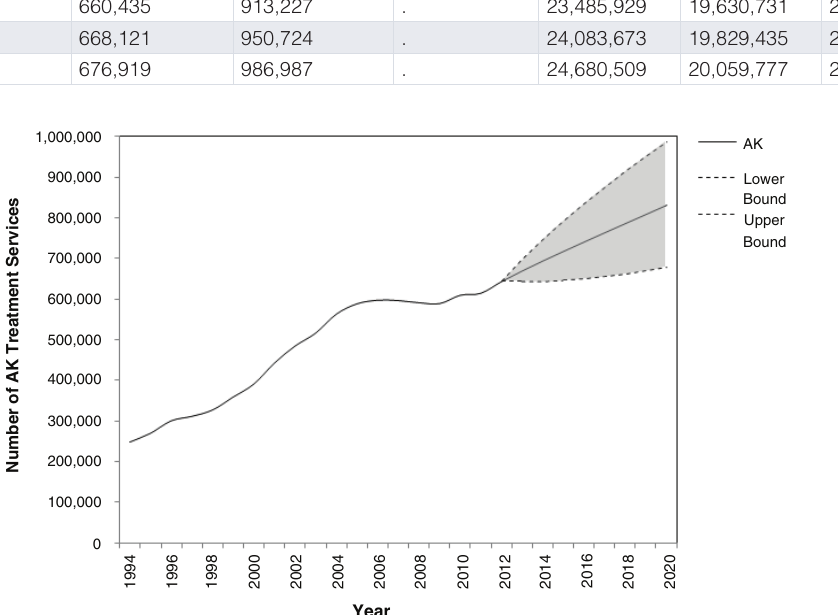
Table 1. Total number of AK treatments, total costs inflated, total costs without inflation and forecasts of AK numbers and costs with upper and lower 95% confidence limits (UCL95 and LCL95). Number of AK Number of AK Total cost in Total cost Total cost Number of AK Total cost Year Treatments Treatments non-deflated in 2012 AU$ in 2012 AU$ Treatments in 2012 AU$ LCL95 UCL95 AU$ LCL95 UCL95 1994 247,515 . . 5,592,597 9,094,440 . . 1995 269,252 . . 6,168,831 9,587,787 . . 1996 299,863 . . 6,975,529 10,565,260 . . 1997 311,091 . . 7,248,143 10,953,532 . . 1998 326,626 . . 7,724,620 11,574,041 . . 1999 358,525 . . 8,593,104 12,687,151 . . 2000 390,535 . . 9,439,584 13,342,203 2001 442,486 . 2002 484,561 2003 516,626 . . . 2004 563,261 . . 2005 588,726 . . 15,470,476 2006 597,756 . . 18,801,665 . . 2007 596,683 . . 16,304,737 18,733,990 . . 2008 591,497 . . 16,618,138 18,298,064 . . 2009 589,286 . . 16,865,300 18,247,035 . . 2010 609,820 . . 17,770,443 18,681,155 . . 2011 614,843 . . 18,327,107 18,650,174 . . 2012 643,622 . . 19,602,097 19,602,097 . . 2013 669,766 642,866 696,666 . 20,364,039 19,399,117 21,328,960 2014 694,371 643,980 744,763 . 21,037,418 19,324,949 22,749,887 2015 718,078 645,821 790,335 19,309,150 24,029,872 2016 741,260 649,137 833,382 22,282,359 19,360,513 25,204,205 2017 764,135